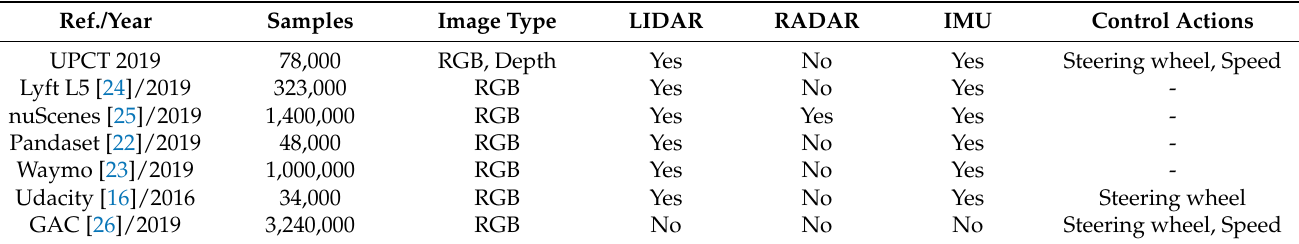
Table 1. Public datasets for autonomous